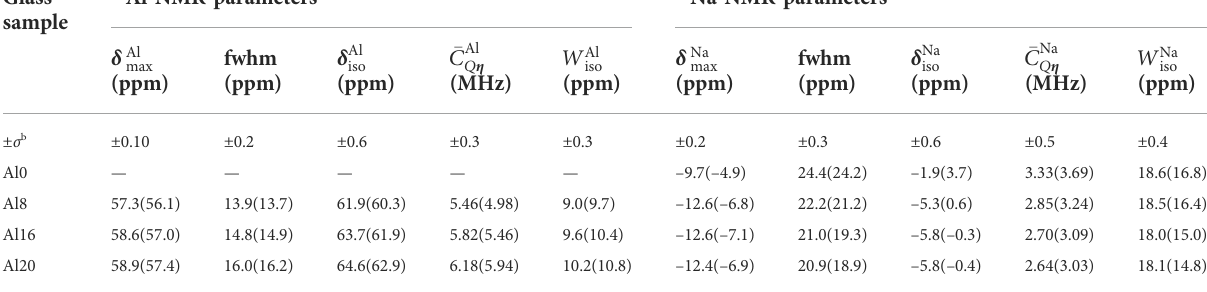
TABLE 2 27 Al and 23 Na NMR parameters before and after chemical strengthening.